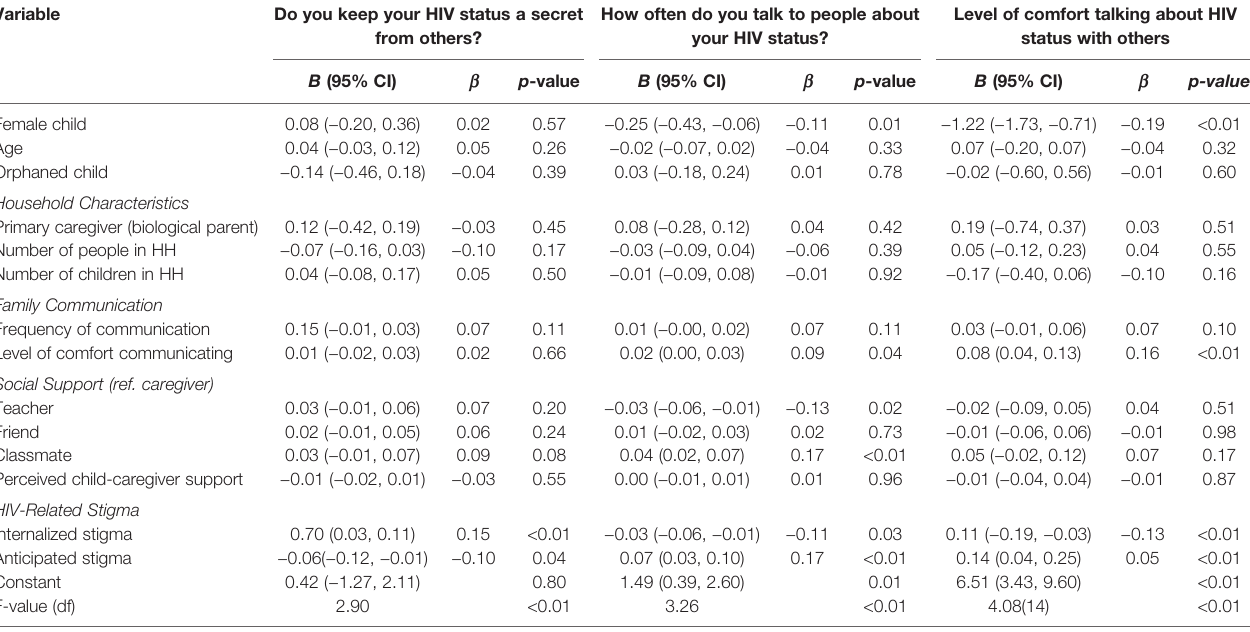
TABLE 3 | Family Communication and Social Support Factors Associated with HIV Disclosure and Disclosure Comfort (N = 702). Variable